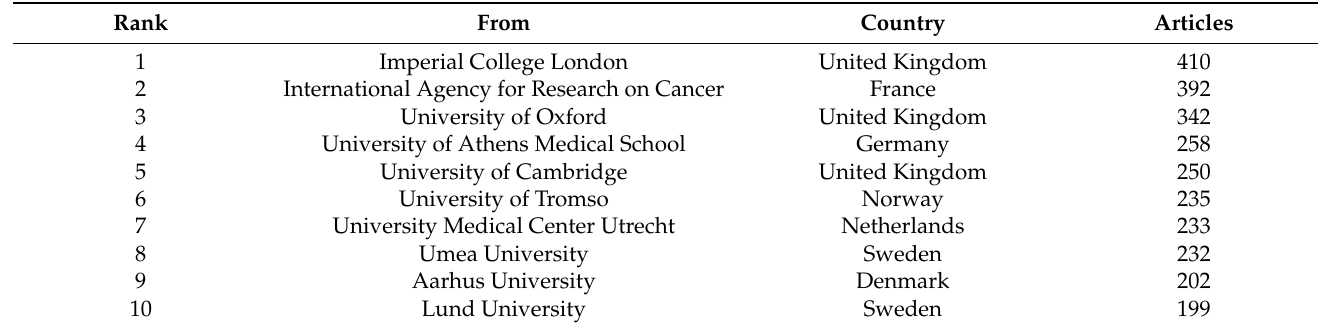
Table 2. Top 10 most affiliation of the authors.